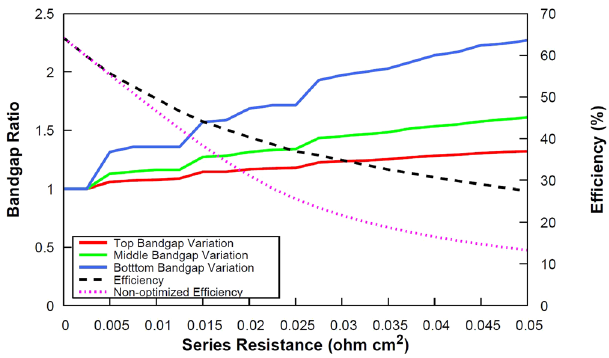
Figure 3. Ratio of optimized and non-optimized electronic gaps for a triple-junction solar cell (red line: top bandgap – green line: middle bandgap – blue line: bottom bandgap) and corresponding efficiency (purple dotted line: non-optimized cell – black dashed line: optimized cell), and as a function of the series resistance value, assuming an illumination of 5000